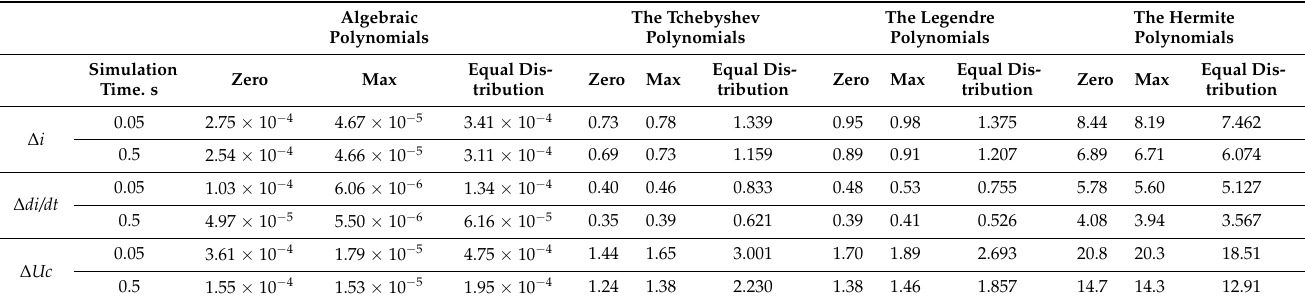
Table 1. Relative mean quadratic deviations of simulating errors in